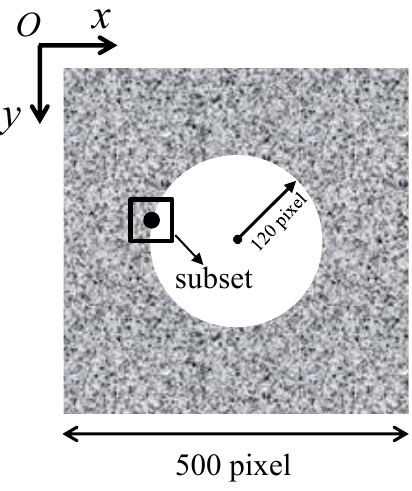
Figure 1. Speckle image with subset located near the specimen